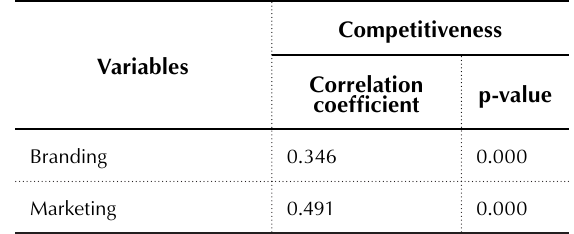
Table 7. Correlations (competitiveness vs business activity’s